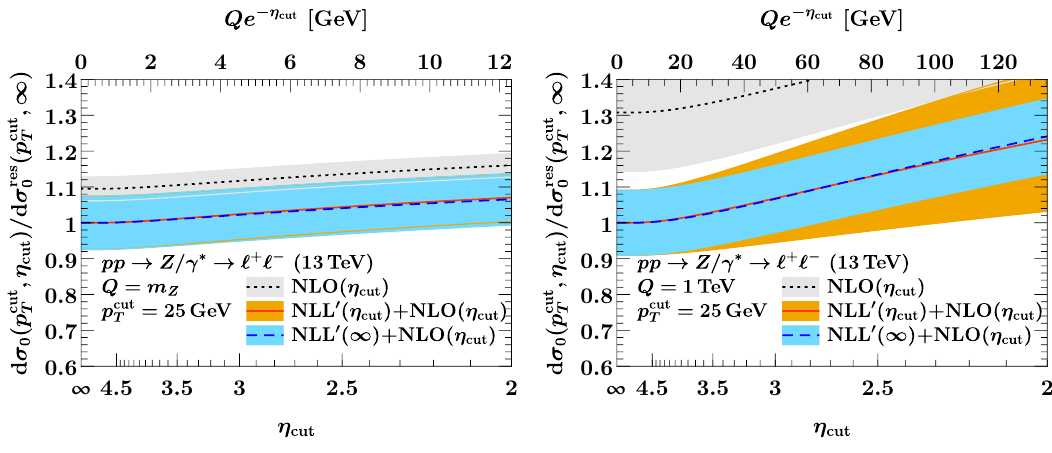
Figure 11 . The 0-jet cross section for Drell-Yan at Q = m Z and p cut and p cut = 25 GeV (right) as a function of (cid:17) cut . The same observable ( (cid:27) 0 ) is calculated in three T di(cid:11)erent ways, shown by the di(cid:11)erent bands, as described in the text. For better readability, all results are normalized to the resummed central value at (cid:17) cut =